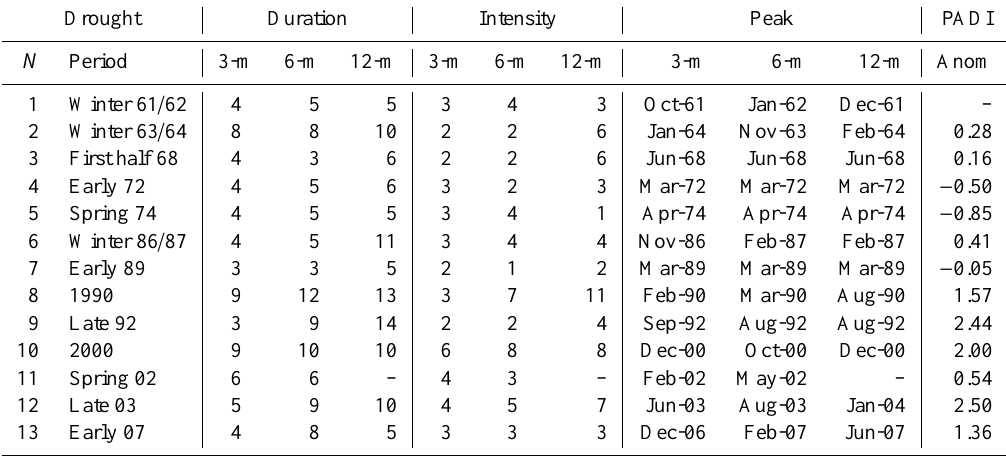
Table 3. Most relevant drought events from 1961 to 2010 in the Carpathians. Drought Duration Intensity